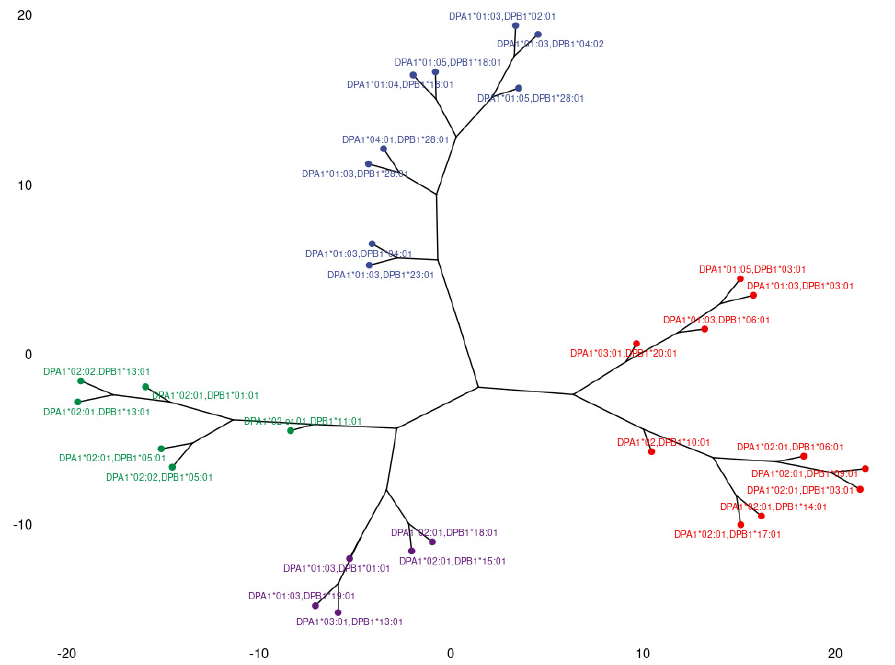
Figure 6. Dendrogram representing anti-HLA-DP response correlations, based on Minkowski dis- tances of antigen specific feature vectors. Three main branches corresponding to distinct groups of responses are